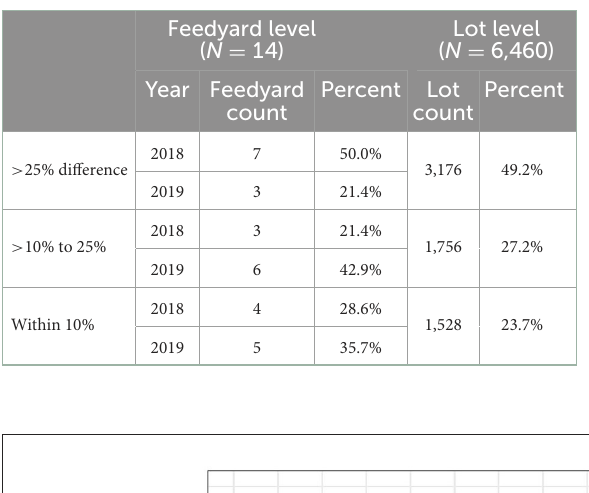
TABLE 2 The percent difference between the nDDD and the CDoA, expressed as a percent of the CDoA value, for all indications combined.